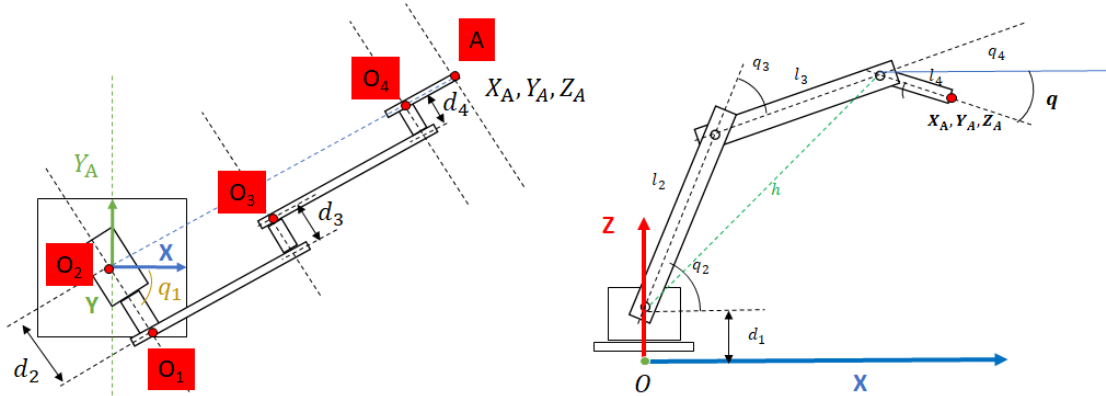
Figure 3. Representation of the reference frames and the joint coordinates used in the kinematics calculation of the